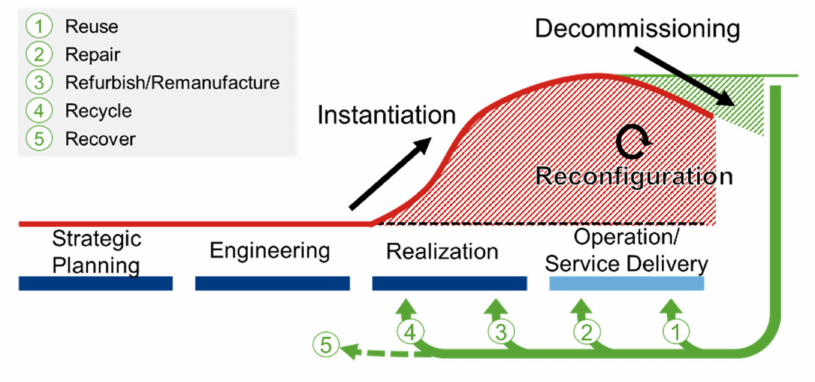
Figure 9. Lateral view of the gPLC: differentiation between product class and